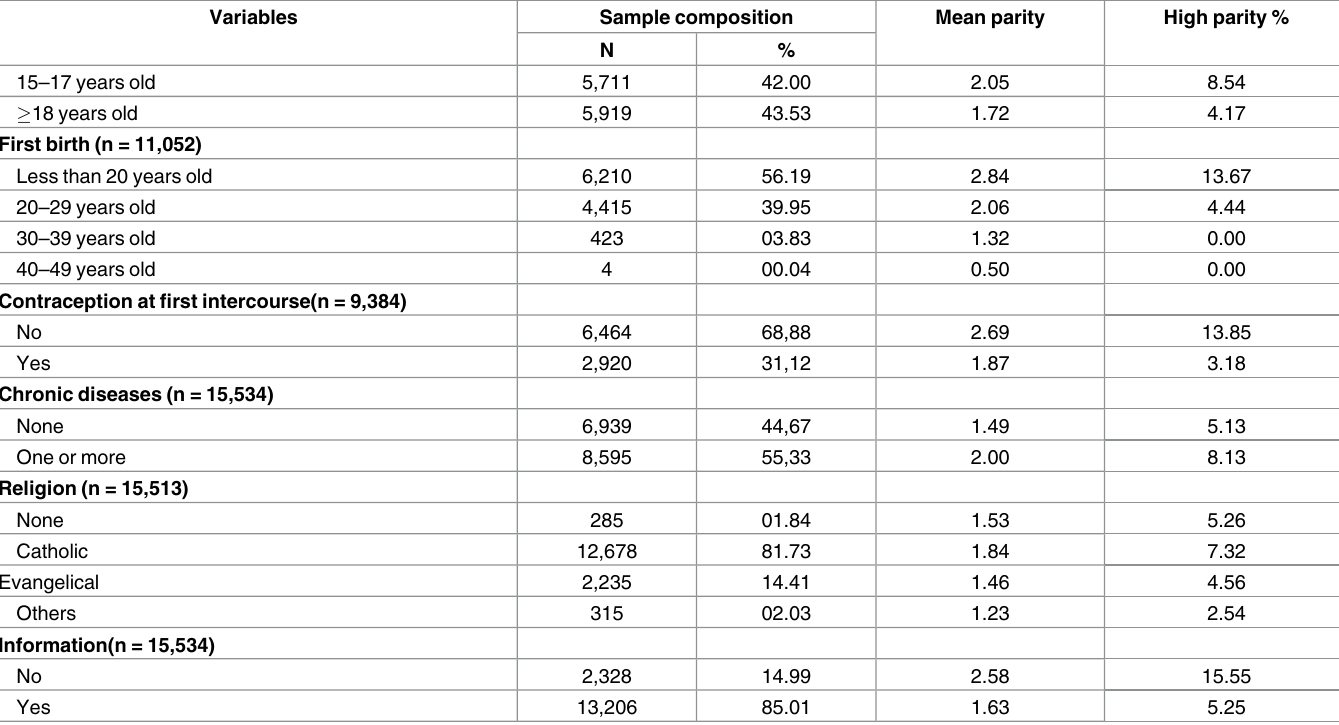
before age 20 (2.84 children per woman), who did not use contraception at first sexual inter- course (2.69 children per woman) and had first sexual intercourse before age 15 (2.58 children per woman). (Table